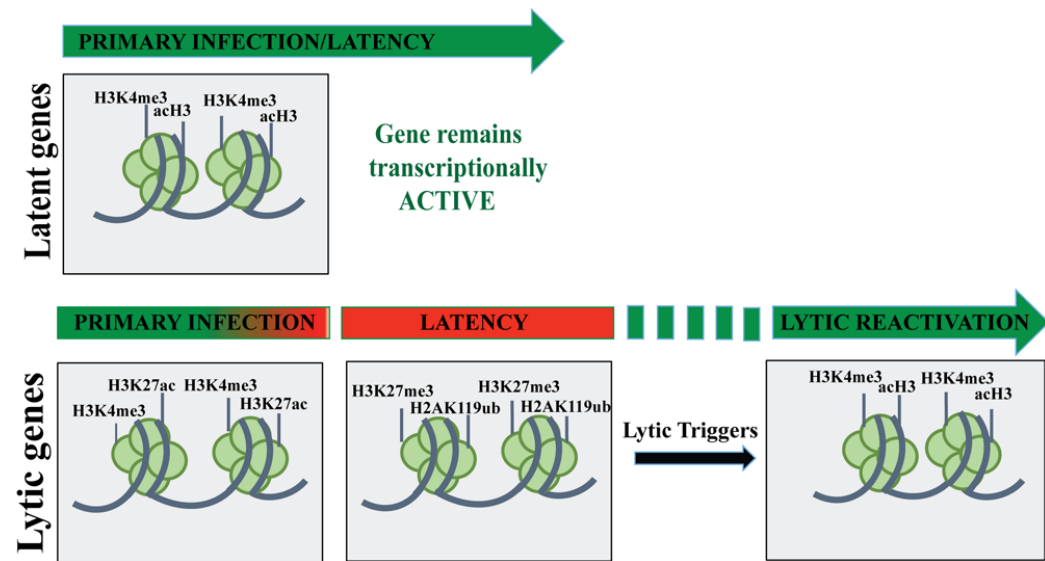
Figure 2. The chromatin landscape of the KSHV genome during various phases of viral life cycle. Following primary infection, promoters of the key latent genes get epigenetically modified with activating histone marks (H3K4me3/acH3) resulting in the expression of those genes throughout the viral life cycle. In contrast, KSHV lytic gene promoters possess either H3K27Ac/H3K4Me3-rich, active chromatin or H3Ac/H3K4Me3/H3K27Me3-rich bivalent chromatin. During latency, the lytic gene promoters are epigenetically modified with H3K9Me3/H3K27Me3 marks to form a heterochromatin. However, upon reactivation these repressive histone marks are enzymatically removed and gets modified with the activating histone marks